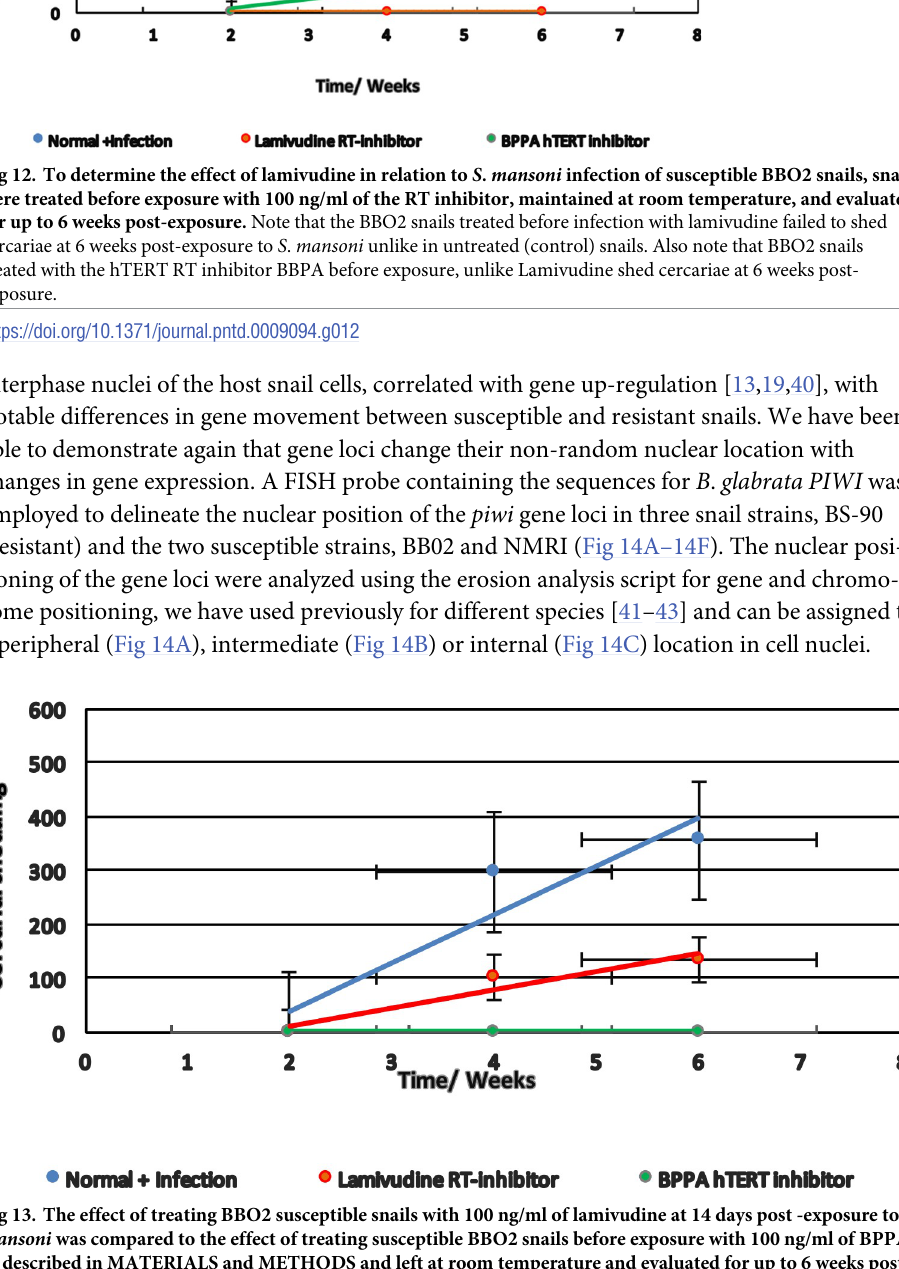
Fig 13. The effect of treating BBO2 susceptible snails with 100 ng/ml of lamivudine at 14 days post -exposure to S . mansoni was compared to the effect of treating susceptible BBO2 snails before exposure with 100 ng/ml of BPPA as described in MATERIALS and METHODS and left at room temperature and evaluated for up to 6 weeks post- exposure. Note that the BBO2 snails treated before S . mansoni exposure with 100 ng BPPA failed to shed cercariae at 6- weeks post- exposure unlike in untreated (control) snails. Also note that BBO2 snails treated with lamivudine at 14 days after infection shed cercariae at 6 weeks